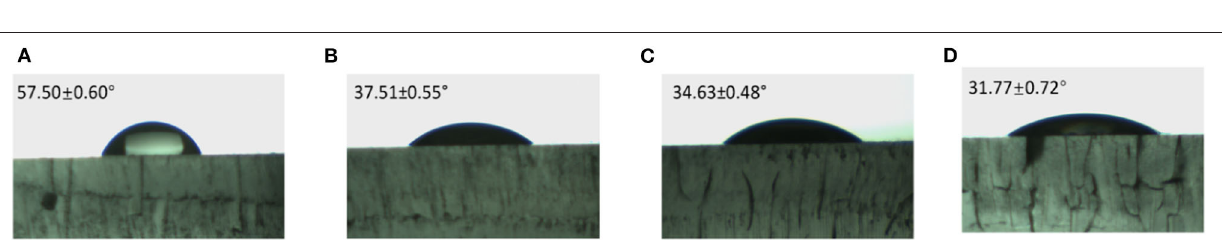
of the surface became blurry after 4-min treatment, which was caused by the exposure to plasma. The static CA of water droplets on bare glass surfaces was θ = 57.50 ◦ ± 0.60 ◦ , indicating surfaces were hydrophilic. In comparison, the CA range of the different time treated glass surfaces are from θ = 37.51 ◦ ± 0.55 ◦ to θ = 31.77 ◦ ± 0.72 ◦ , showing a higher wettability than bare glasses. Figure 7 indicates the hydrophobic properties of Gr-coated steels after 500 ◦ C sintering treatment. The CA of bare steel is θ = 43.55 ◦ ± 0.3 ◦ . In comparing a with b , the Gr coating without sintering increased the CA to θ = 83.99 ◦ ± 0.7 ◦ , which is still considered as a hydrophilic surface ( < 90 ◦ ). The coatings without sintering were observed to be unstable and easily broken by scratching. Graph